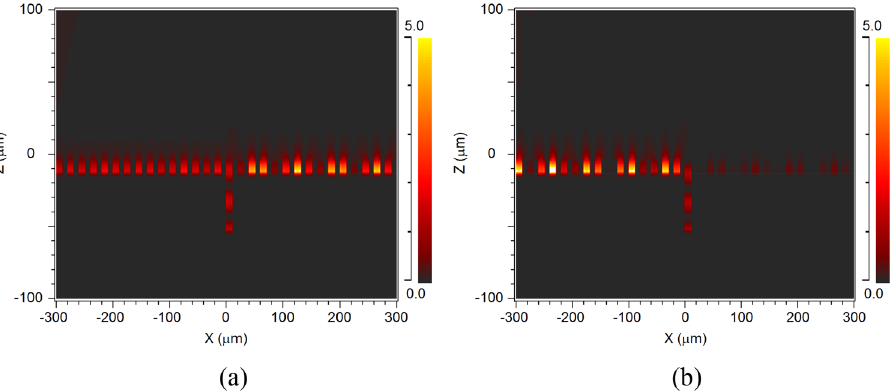
Figure 5. Two-dimensional field distribution of EM wave with a frequency of 3.75 THz obtained through grating with a single grey groove of varying refractive index (Δ d = 40 μm). The increased refractive indices of the single groove are Δ n = 0.5 ( a ), Δ n = 0.6 ( b ).